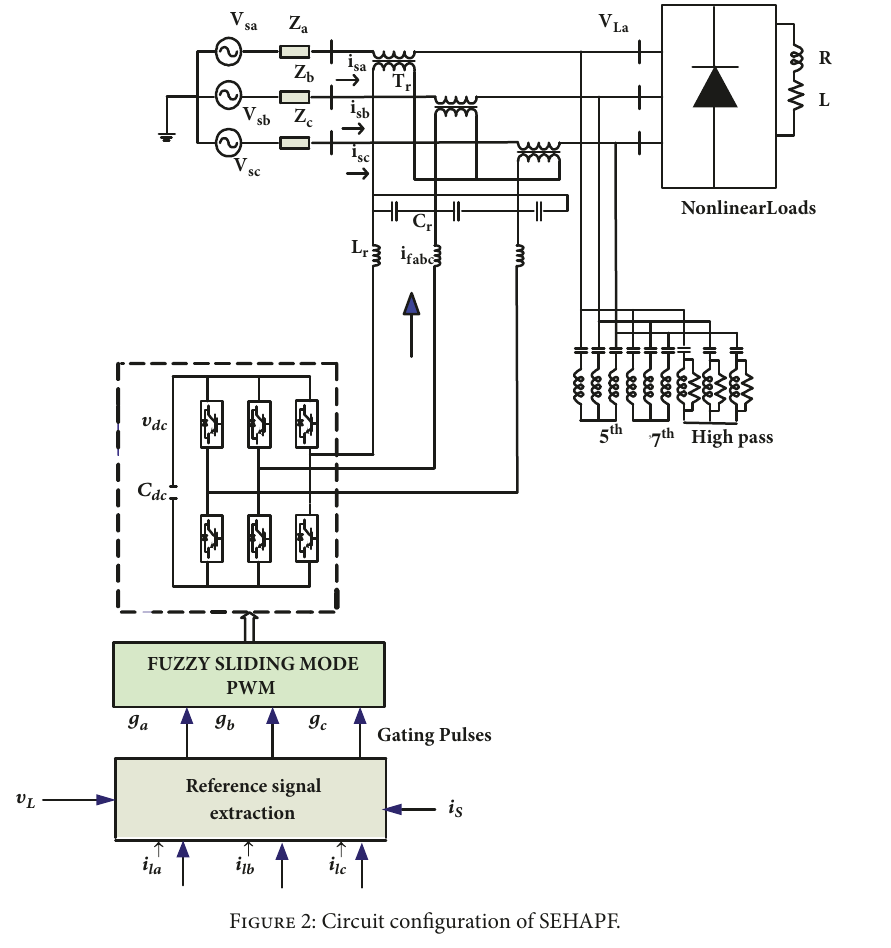
Figure 2: Circuit configuration of SEHAPF.